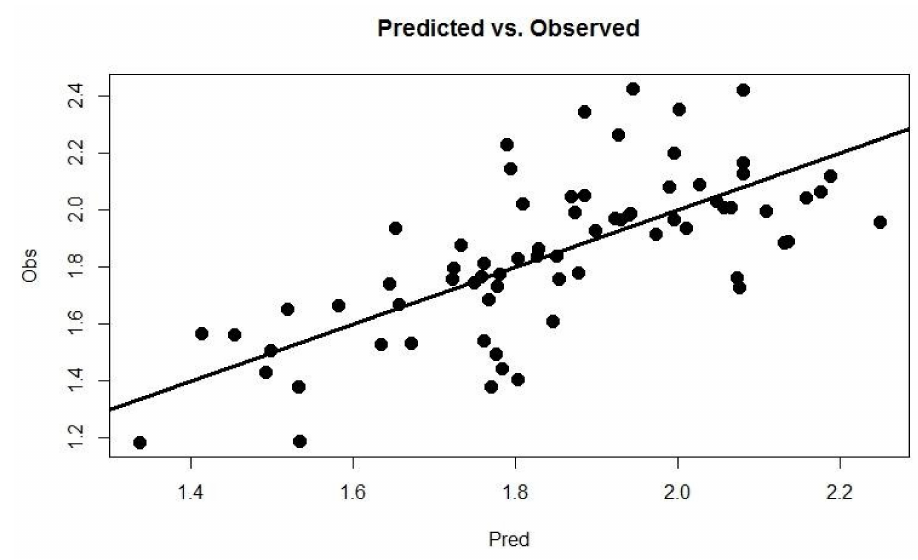
Figure 6. Scatterplot of predicted (RK model) vs. observed values. The spatial distribution of SOC obtained through RK is reported in Figure 7.